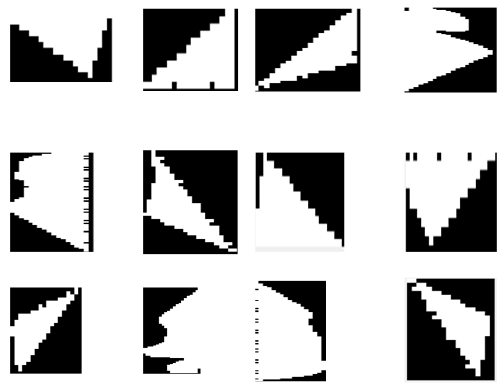
Figure 3. Example image of the human silhouette with centroid.